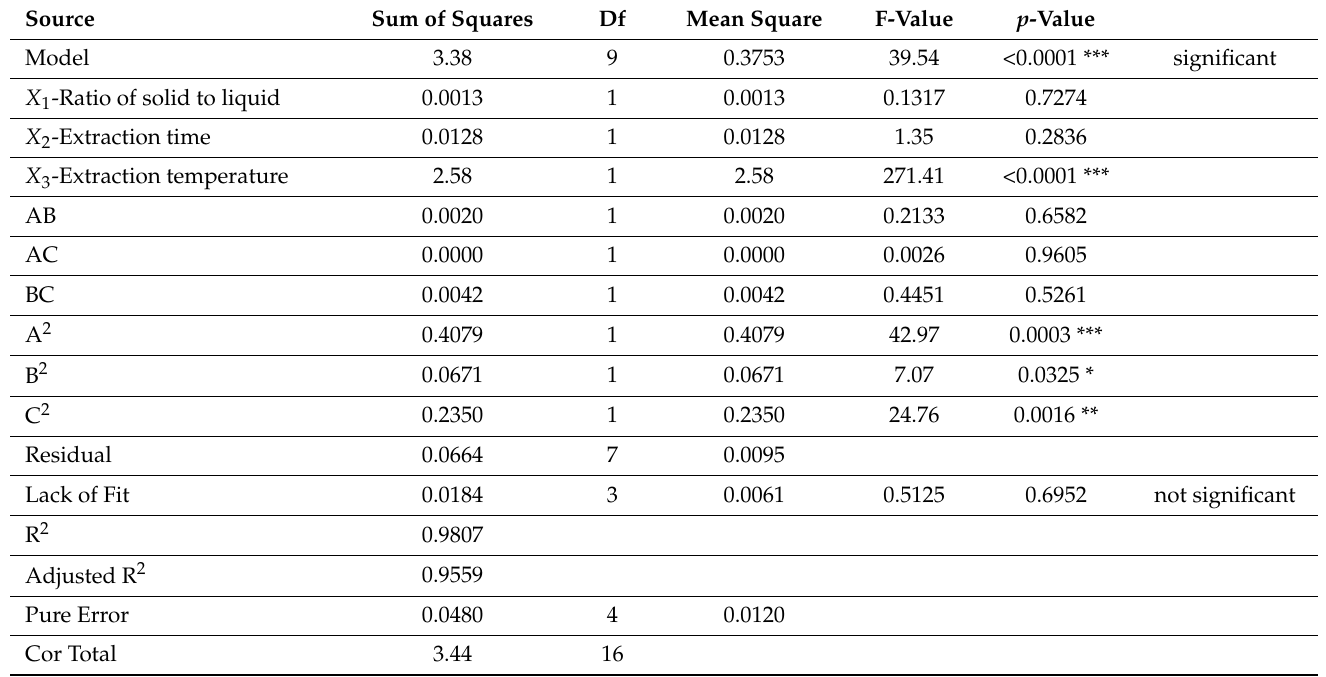
Table 2. Variance analysis of Box-Behnken design for MAP-2 yield.